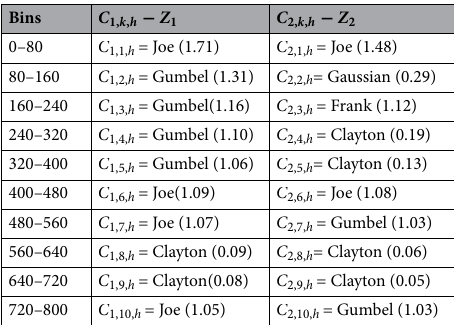
Table 3. The univariate spatial copulas for each bin.